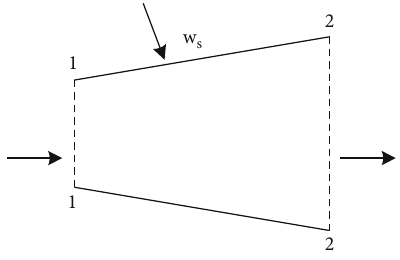
Figure 2: A system with only wind resistance loss.